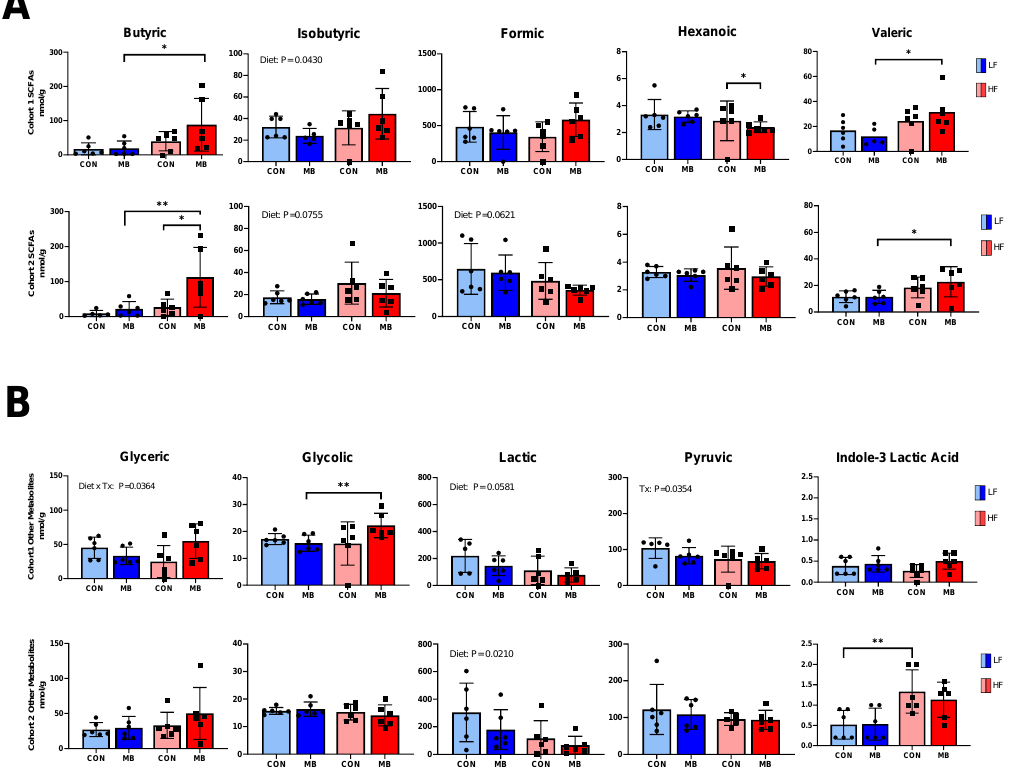
Figure 6. E ff ect of MB supplementation on fecal microbial metabolites in cohort 1 and cohort 2. ( A ) Fecal